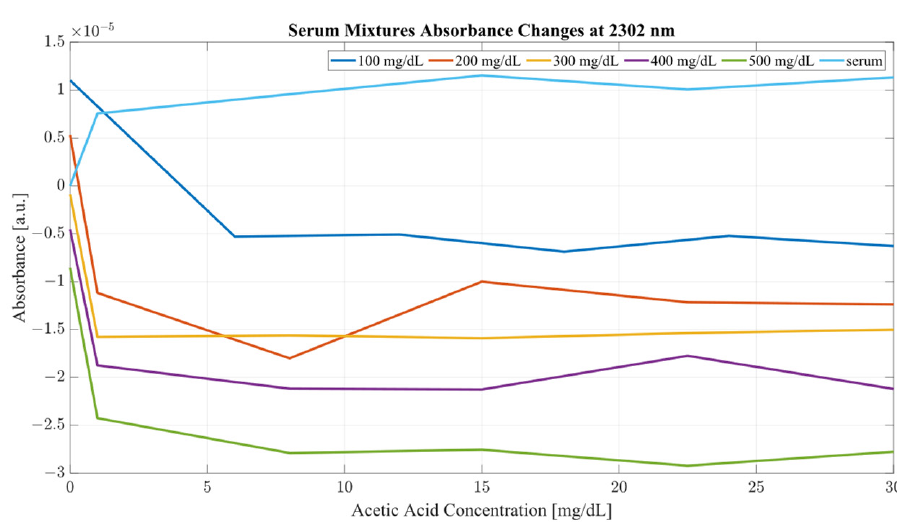
Figure 9. Serum mixture absorbance changes at 2302 nm. Table 1. Statistical analysis of the absorbance variance.